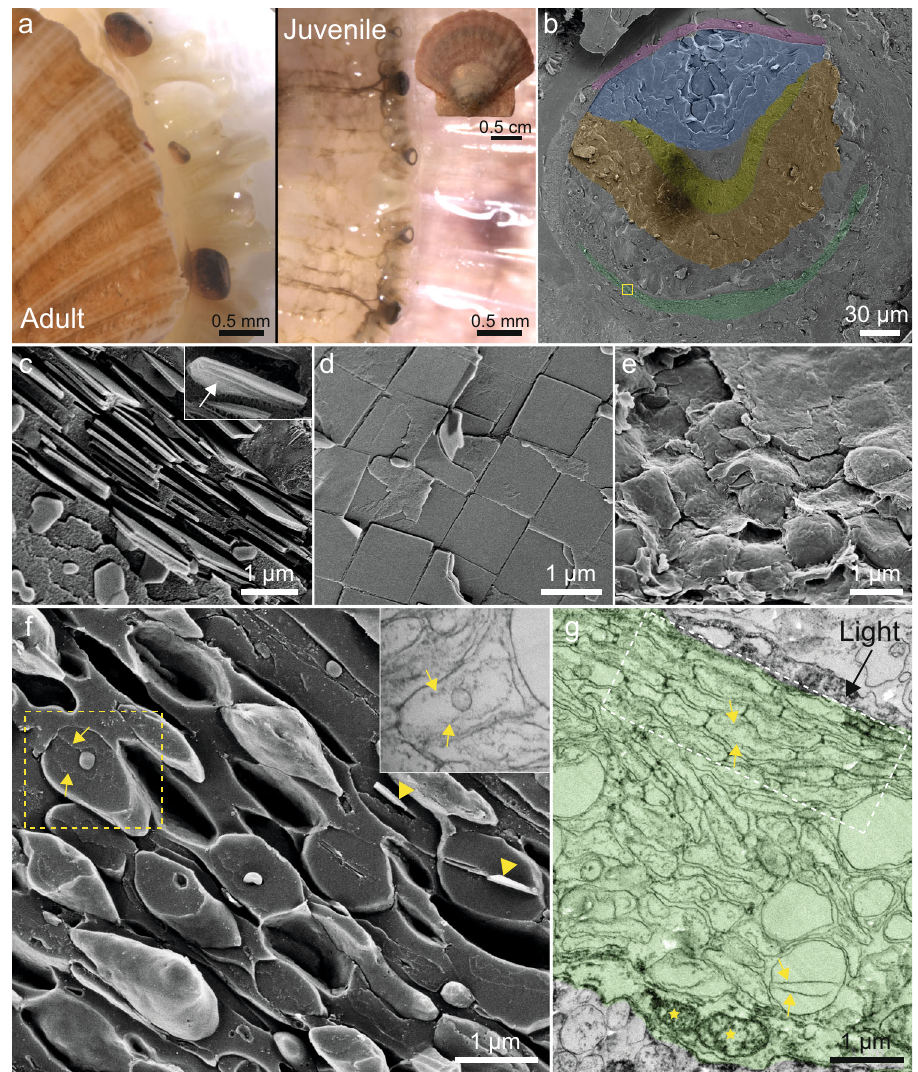
Fig. 1 | The image-forming mirror in the eyes of an adult and juvenile scallops. a Stereomicroscopeimagesofnumerouseyesintheuppermantleofanadult(left) and a juvenile (right) scallop. Insert; a juvenile scallop (approximately 20mm in diameter). b Pseudo-colored cryo-SEM micrograph of a freeze-fractured eye of a juvenile scallop approximately 230 µ m in diameter. Purple; cornea, blue; lens, yel- low;distalretina,orange;proximalretina,green;themirrorregion.Theyellowbox is the area shown in high magni fi cation in ( f ). c , d Cryo-SEM micrographs of the mirrorregioninanadultscallopviewedperpendicularto( c )andalong( d )theoptic axis. Insert in ( c ) shows the delimiting membrane of the iridosome (white arrow)